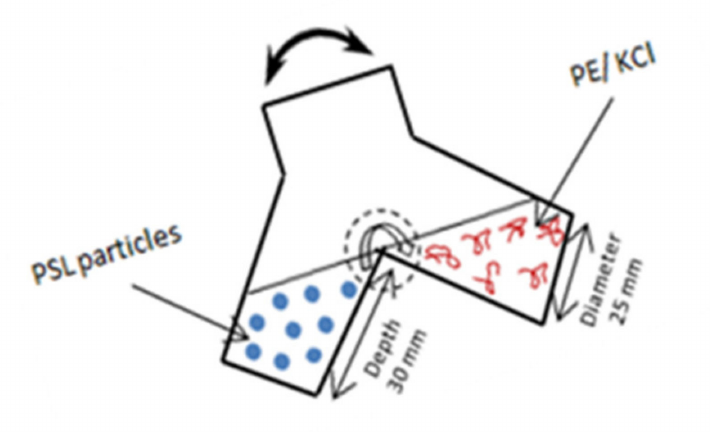
Figure 1. Schematic illustration of an end-over-end apparatus used for mixing